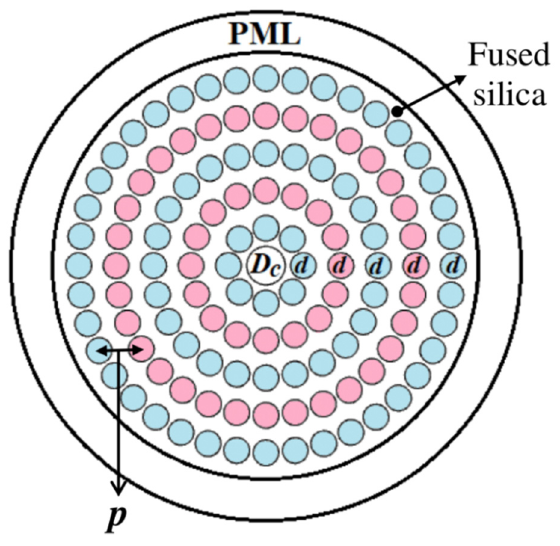
Figure 1. A 2D view of the proposed sulfuric acid concentration level detector.